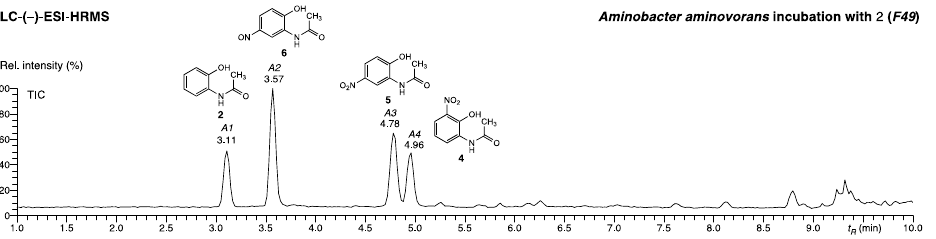
Figure 2. LC-(–)-ESI-HRMS chromatogram (Waters Acquity BEH 100 × 2 mm, 1.7 µm column) of F49 ( Aminobacter aminovorans) from total culture extract after incubation with 2 . Chromatographic peaks A1-A4 belong to 2 and its conversion products 4 , 5 , and 6 .